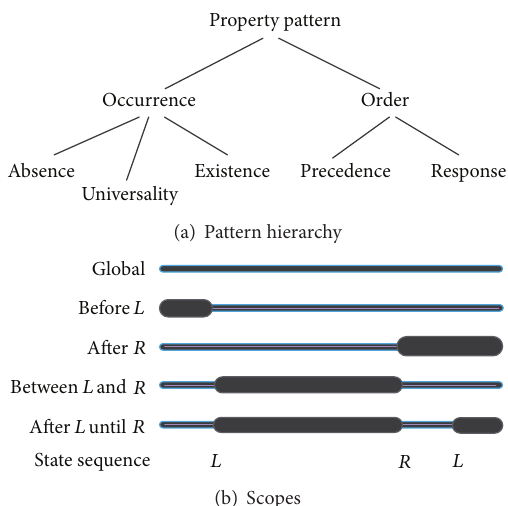
Figure 3: The pattern hierarchy and the scopes in